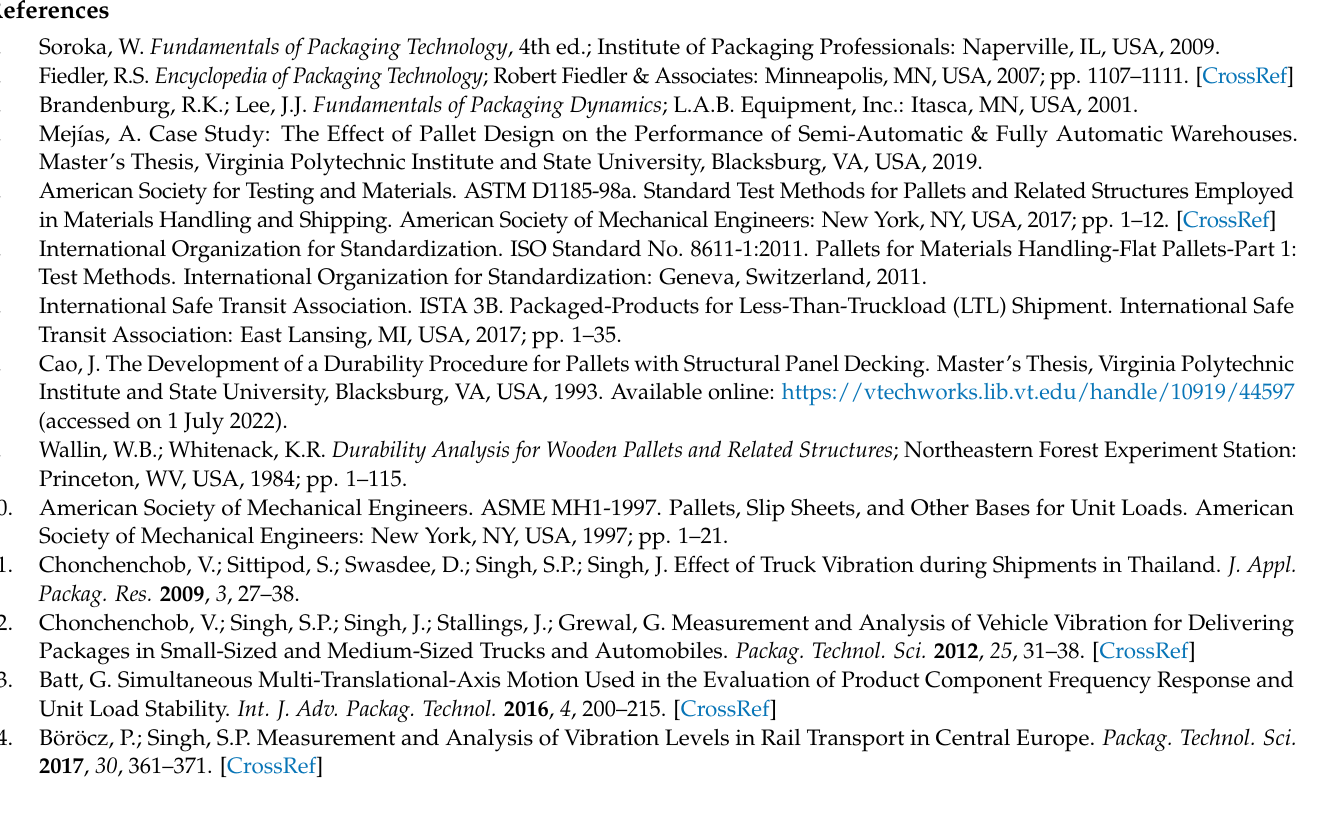
Means that do not share a letter are significantly